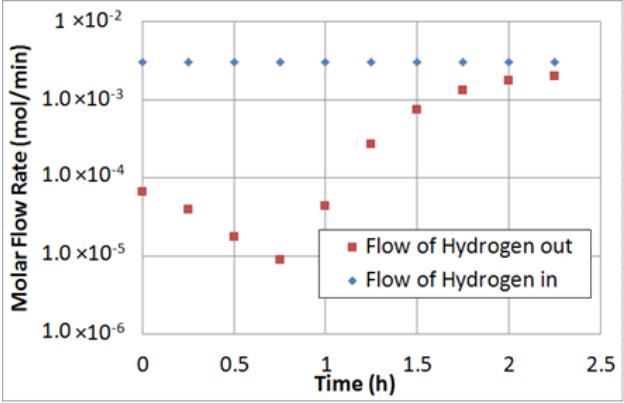
Figure 6. Molar flow rate of H 2 in and out of the MR during coke deposition analysis.